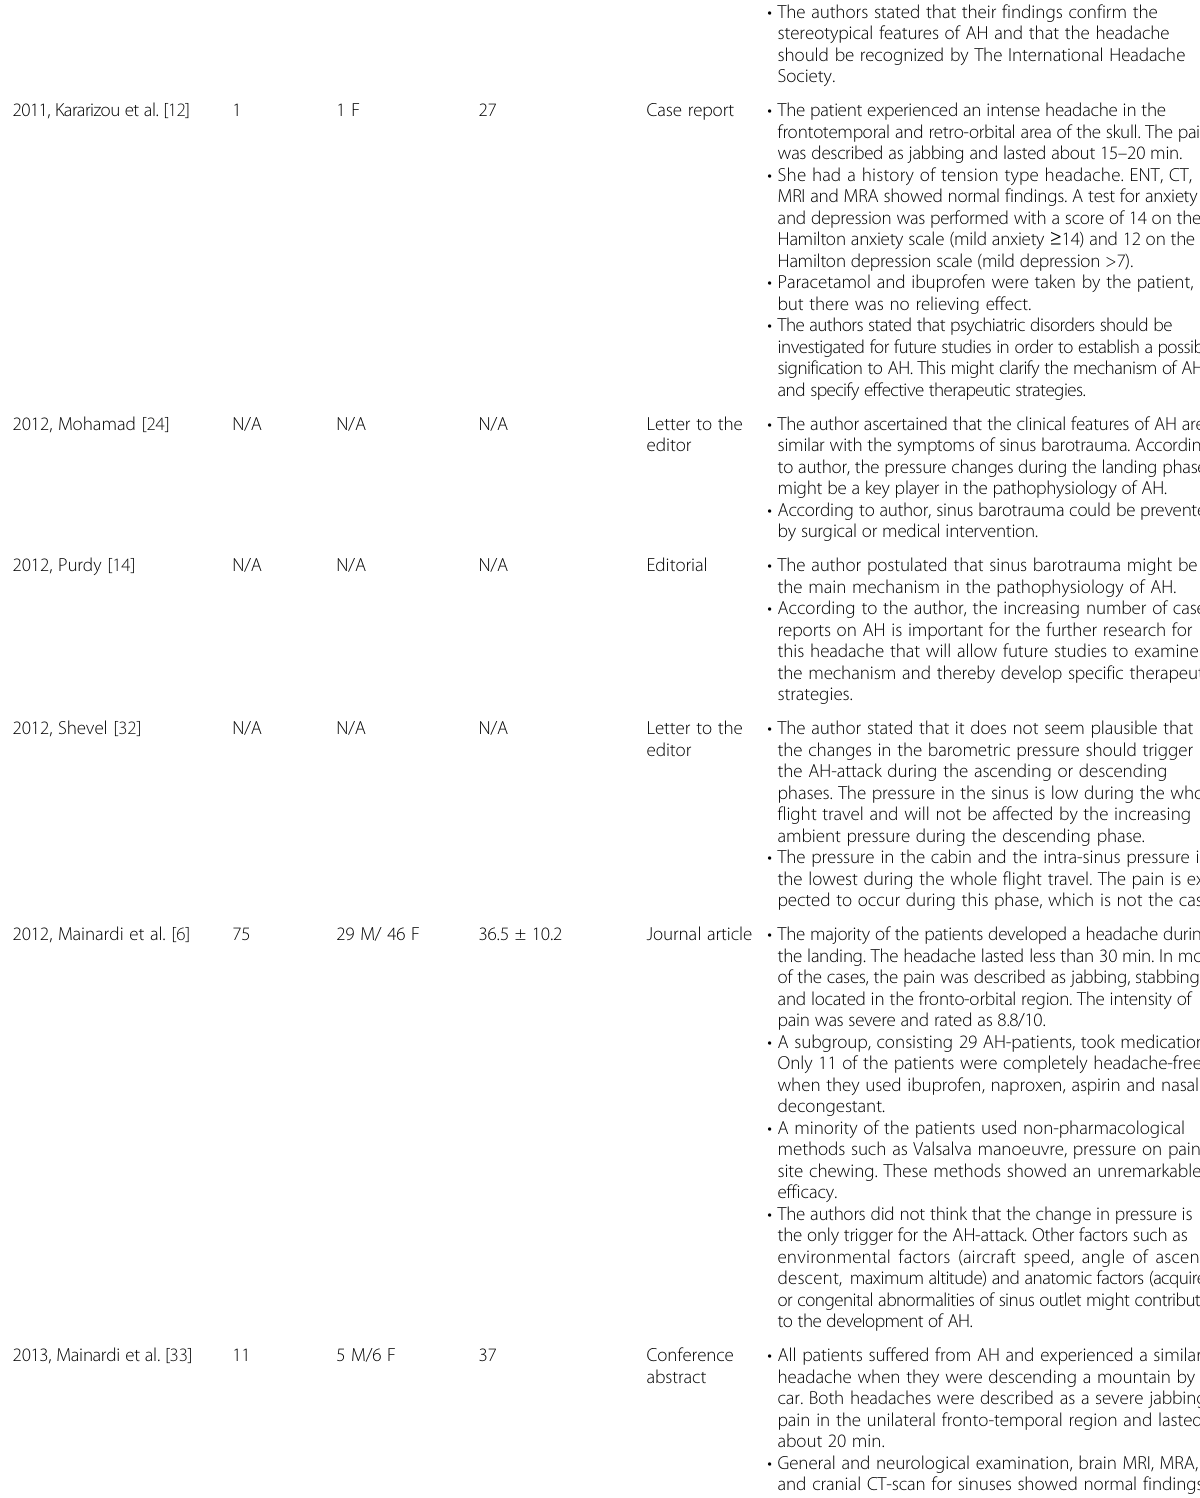
Table 1 Demographic characteristics and main outcomes of the current literature regarding headache attributed to airplane travel (Continued)